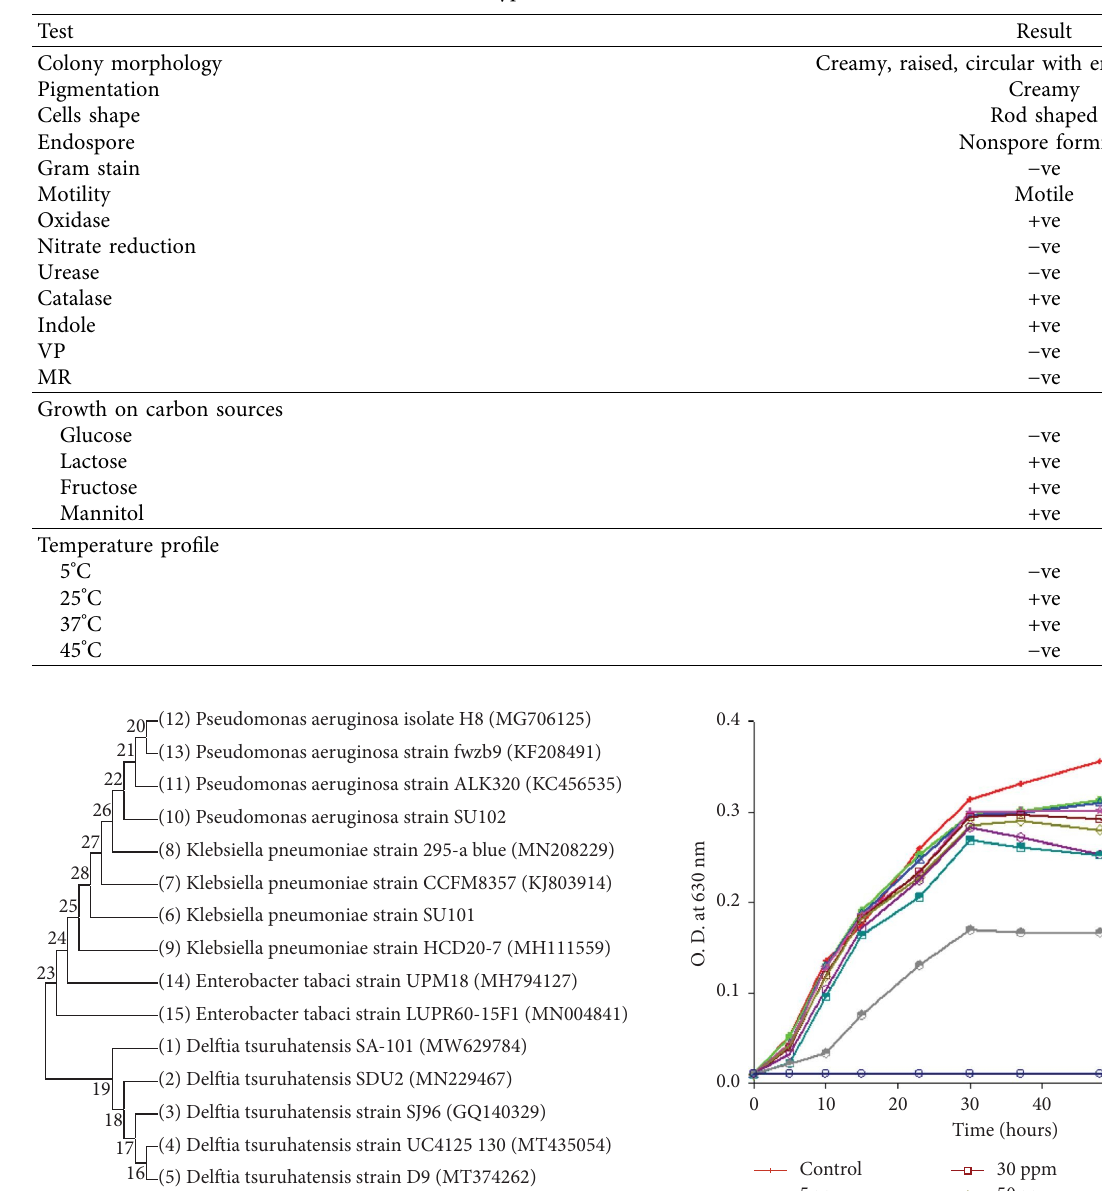
Table 1: Phenotypic characteristics of the bacterial isolate SA-101.